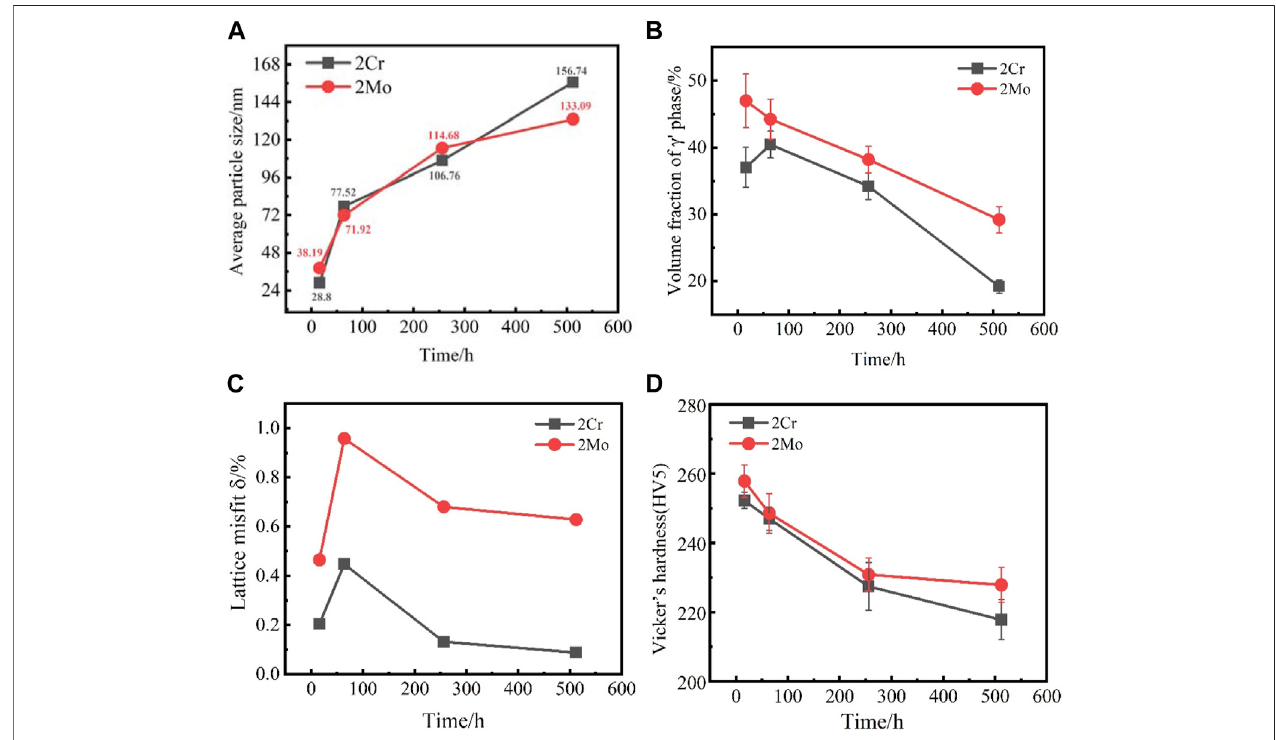
FIGURE 5 | The average size of the γ ′ phase and lattice mis fi t of 2Cr and 2Mo superalloys after aging at 1073 K: (A) the average size of the γ ′ phase, (B) volume fraction of the γ ′ phase, (C) lattice mis fi t, and (D) Vicker ’ s hardness.